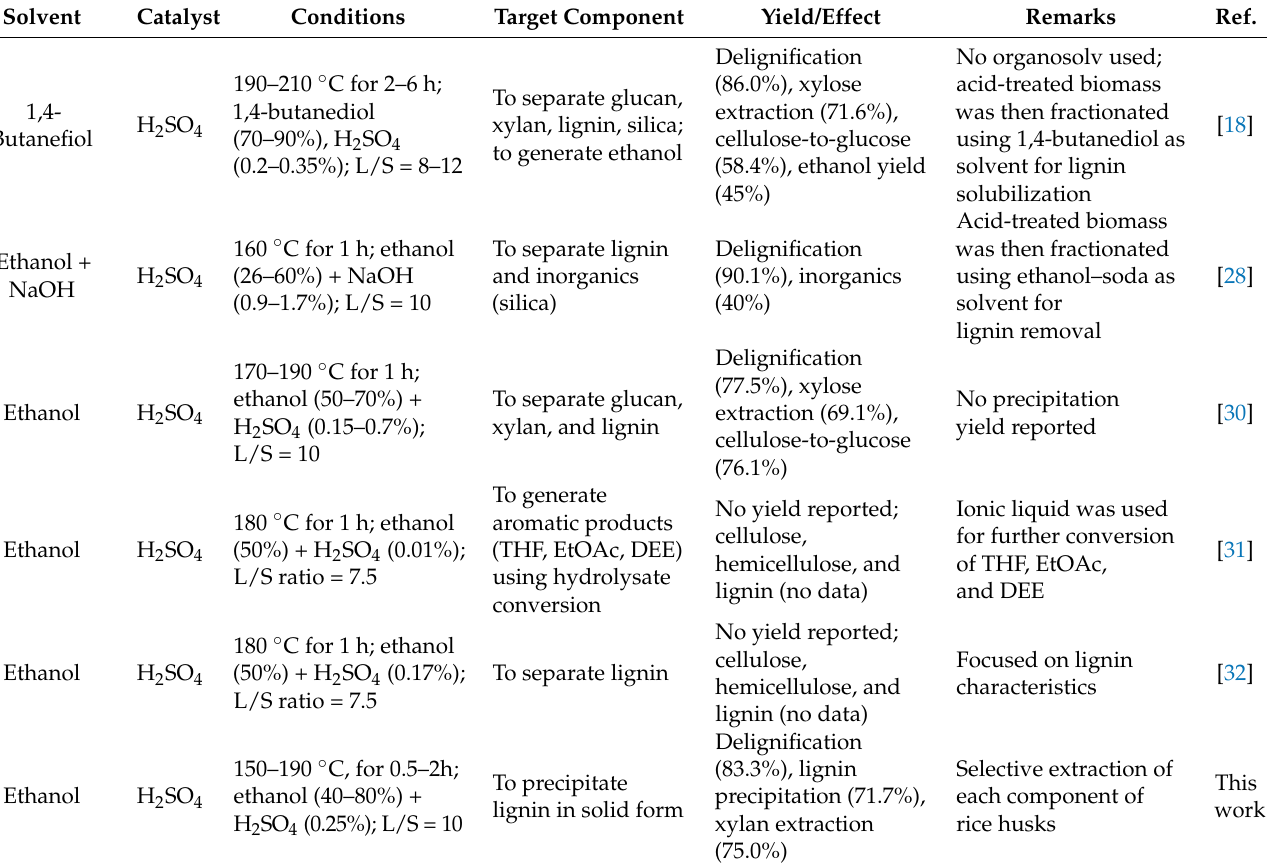
Table 2. Previous reports on lignin removal from rice husks using organosolv